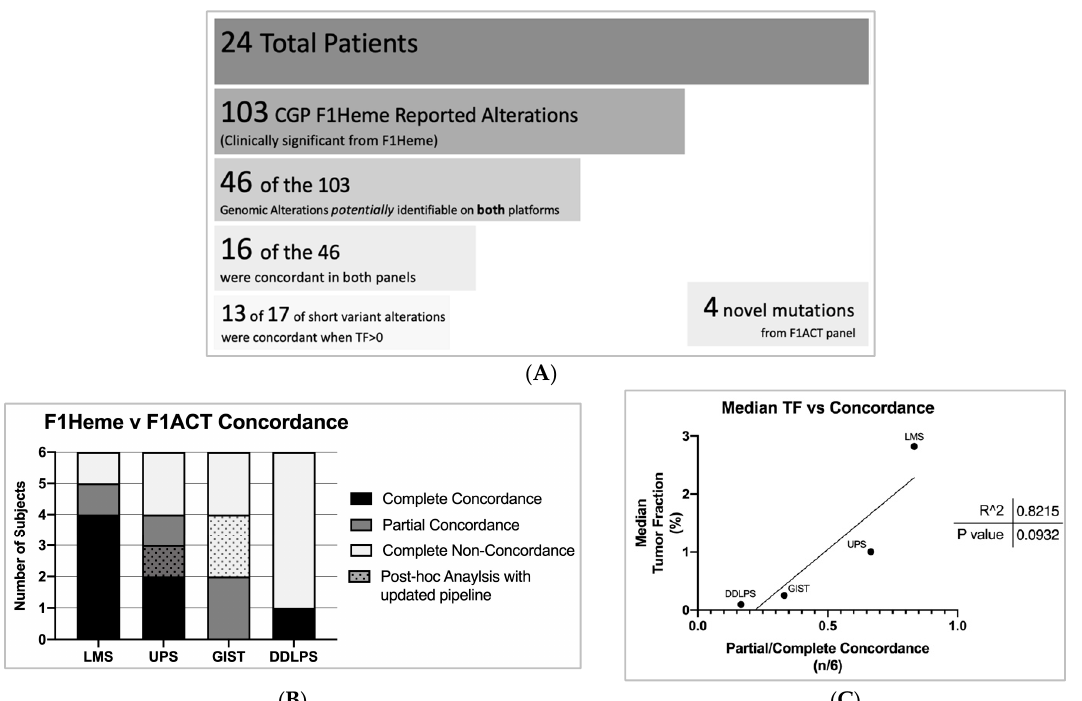
Figure 3. ( A ) Twenty-four subjects who underwent F1Heme profiling identified a total of 103 genomic alterations. Of the 103 alterations in F1Heme, the F1ACT assay had the power to detect 46 of those alterations. F1ACT reported 16 / 46 mutations concordant with F1Heme and identified four additional mutations. Six soft tissue sarcomas (STS) subjects failed to report any quantifiable ctDNA estimated TF. For short variants with TF > 0, 13 of 17 alterations were concordant in the liquid / solid CGP. ( B ) Twenty-four subjects (LMS n = 6, UPS n = 6, GIST n = 6, DDLPS n = 6) tumor mutations concordances between F1Heme and F1ACT assays per STS subtype. 7 / 24 subjects acquired complete concordance across tests, 5 / 24 were partially concordant (at least one—but not all—mutations identified), and 12 / 24 subjects failed to identify any original comprehensive genomic profiling (CGP) mutations and were completely non-concordant. LMS subjects harbored the highest concordance. After a software pipeline update that improved the performance of F1ACT’s detection capabilities one UPS subject became completely concordant and two GIST subjects went from completely non-concordant to partially concordant post identifying at least one CGP reported mutation. ( C ) Median estimated TF compared to the fraction of subjects which were either partially or completely concordant per STS subtype.